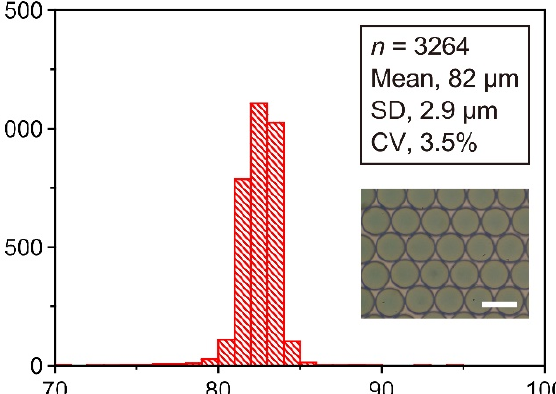
Figure 4. Diameter distribution of the analyzed droplets, showing the total droplet sample size ( n ), mean diameter, standard deviation (SD), and coefficient of variation (CV). Inset: Typical image of a droplet monolayer (scale bar, 100 µm). A standard PMMA/PDMS microchip was used in the experiments. Table 2. Variation of droplet diameter for each experiment.